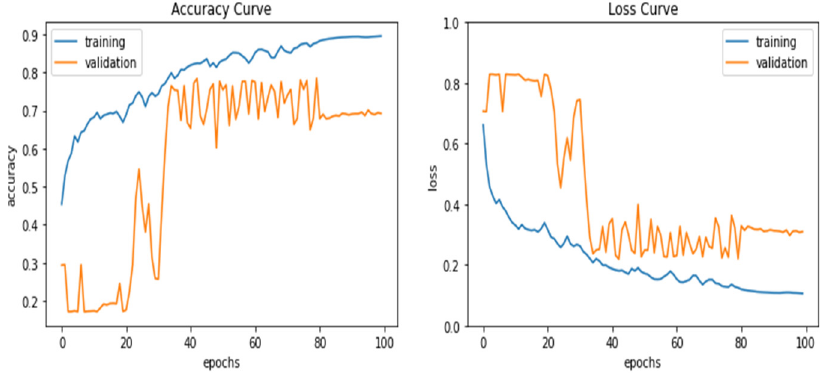
Figure 21. Training and validation curves of accuracy and loss for the RGB case.